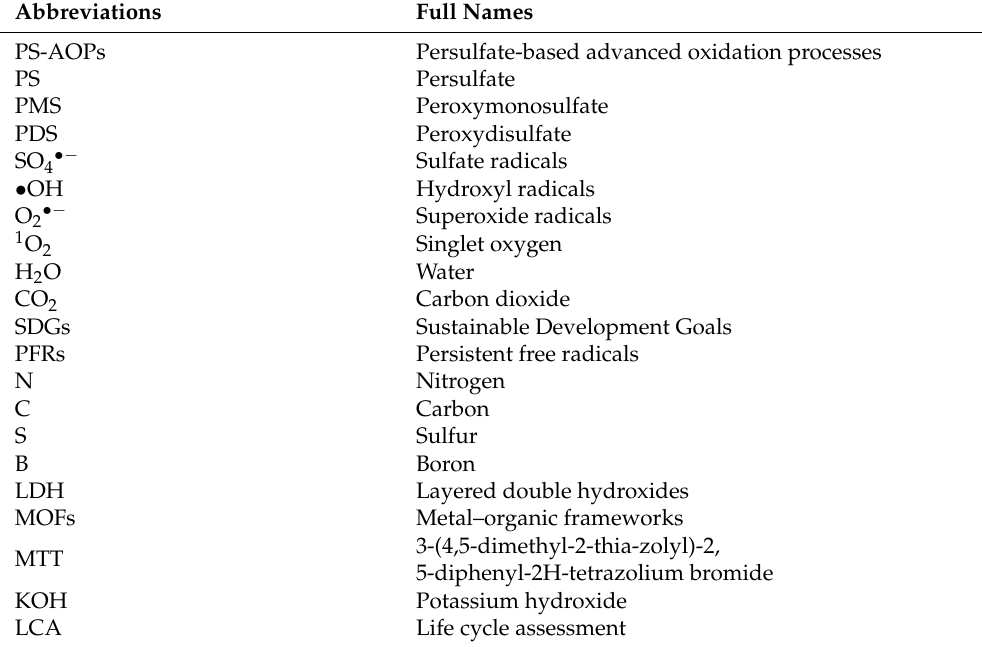
Table 1. List of